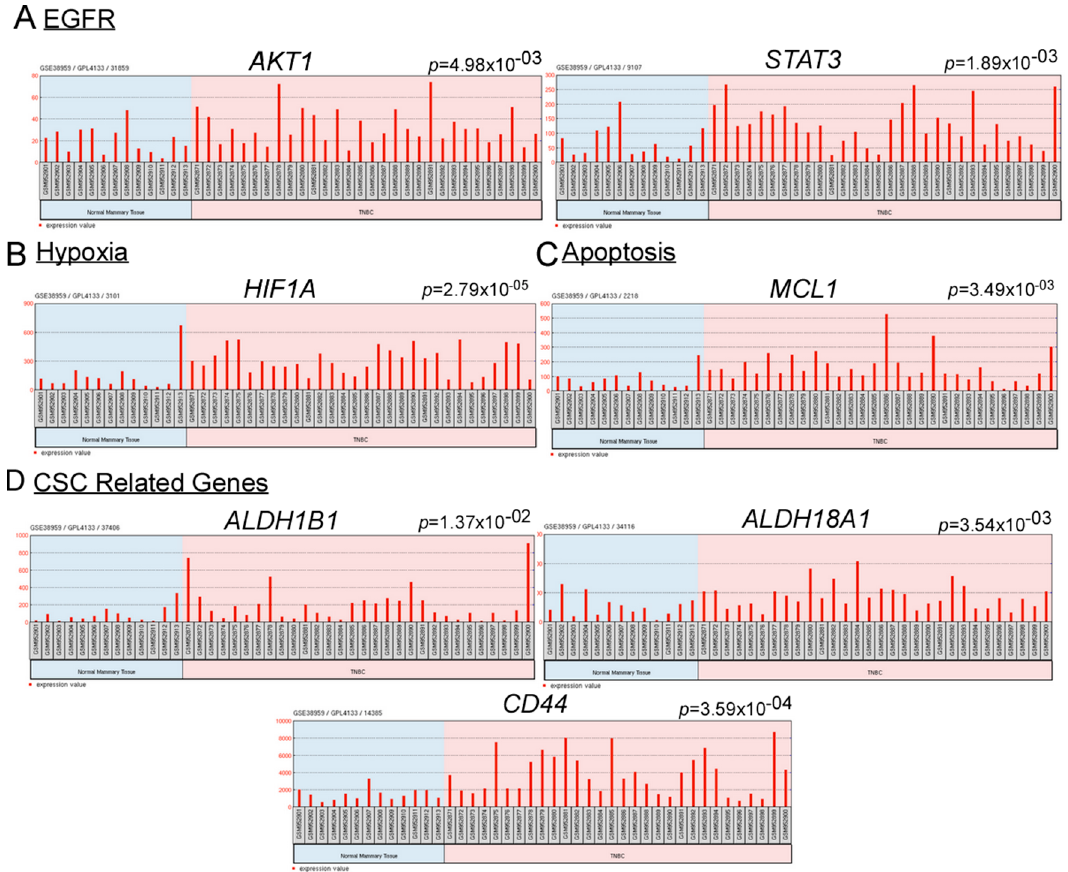
Figure 1. TNBC is associated with high levels of hypoxia, EGFR, stemness-related and anti-apoptosis related gene expression. ( A – D ) The relative expression levels (A.U arbitrary unit) of genes in 30 TNBC and 13 normal mammary tissue samples using the NCBI Gene Expression Omnibus (GEO2R). samples were analyzed using the GPL4133 Agilent-014850 Whole Human Genome Microarray 4 ×